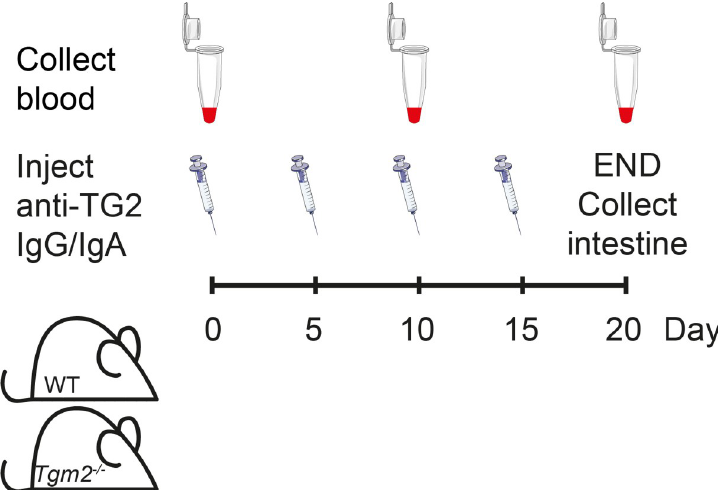
Fig 1. Overview of experimental setup. Anti-TG2 was administered by intravenous injection at the indicated time points. Either a mix of IgG2b and IgG2c (100 μ g each) or IgA (400 μ g) or PBS was given each time. Blood was collected at indicated time points prior to injections. At the end of the experiment, samples of the small intestine were fixed in formalin or embedded in OCT and frozen. The figure was created using elements from Servier medical arts (www.